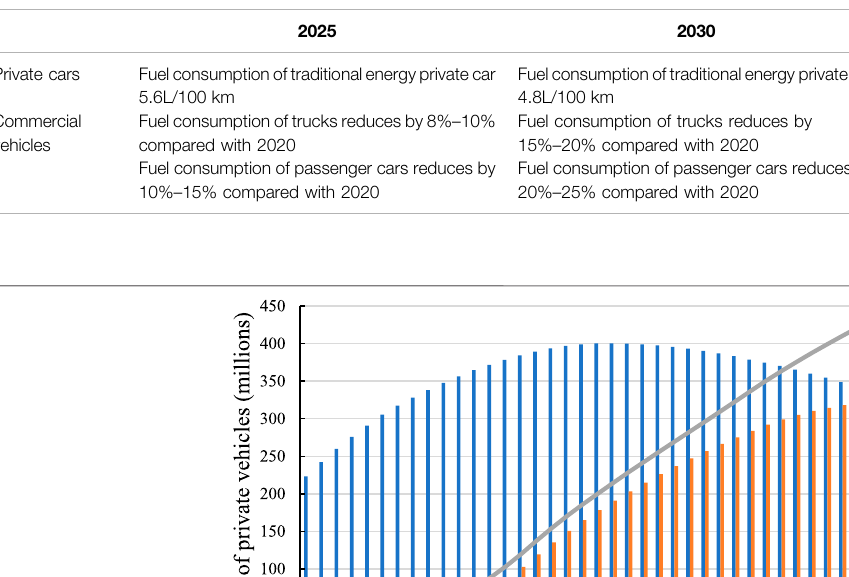
TABLE 1 | Goals of vehicles on energy saving.